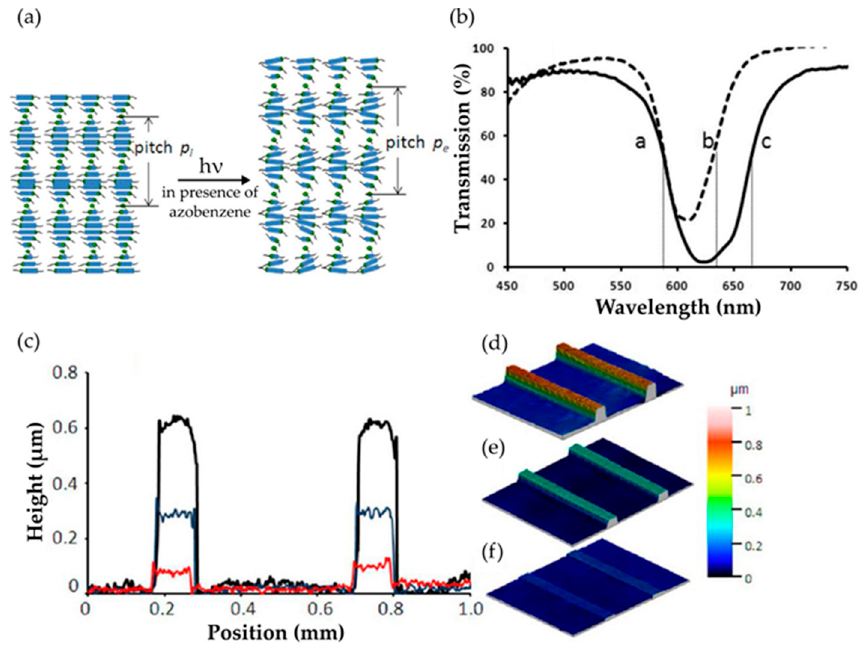
Figure 10. ( a ) Schematic representation of the cholesteric polymer coating before and after exposure with UV light with change in order; ( b ) Transmission spectra of the chiral nematic coating before (solid line) and after UV exposure (dashed line); ( c ) Surface profiles and the 3D view of the topographies made by masked UV exposure of the cholesteric polymer coating with azobenzene moiety (black line in ( c , d )), Tinuvin 328 (blue line in ( c , e )) and an isotropic coating with azobenzene (red line in ( c , f )). Reproduced from [95].